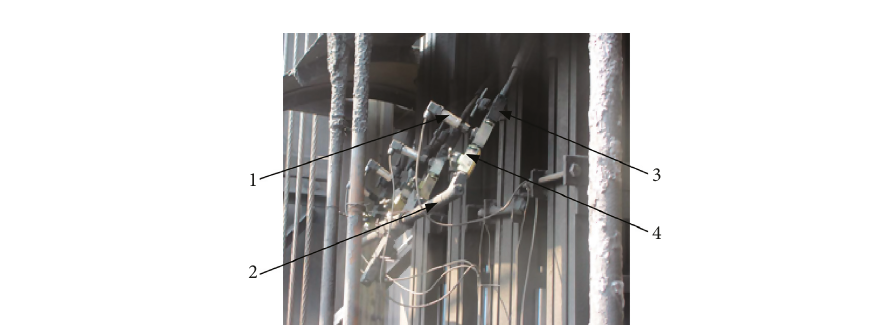
Figure 22: The diagrammatic sketch of the on-site installation of oil pressure sensor.1, oil pressure sensor; 2, connecting pipe; 3, connector; 4, globe valve.